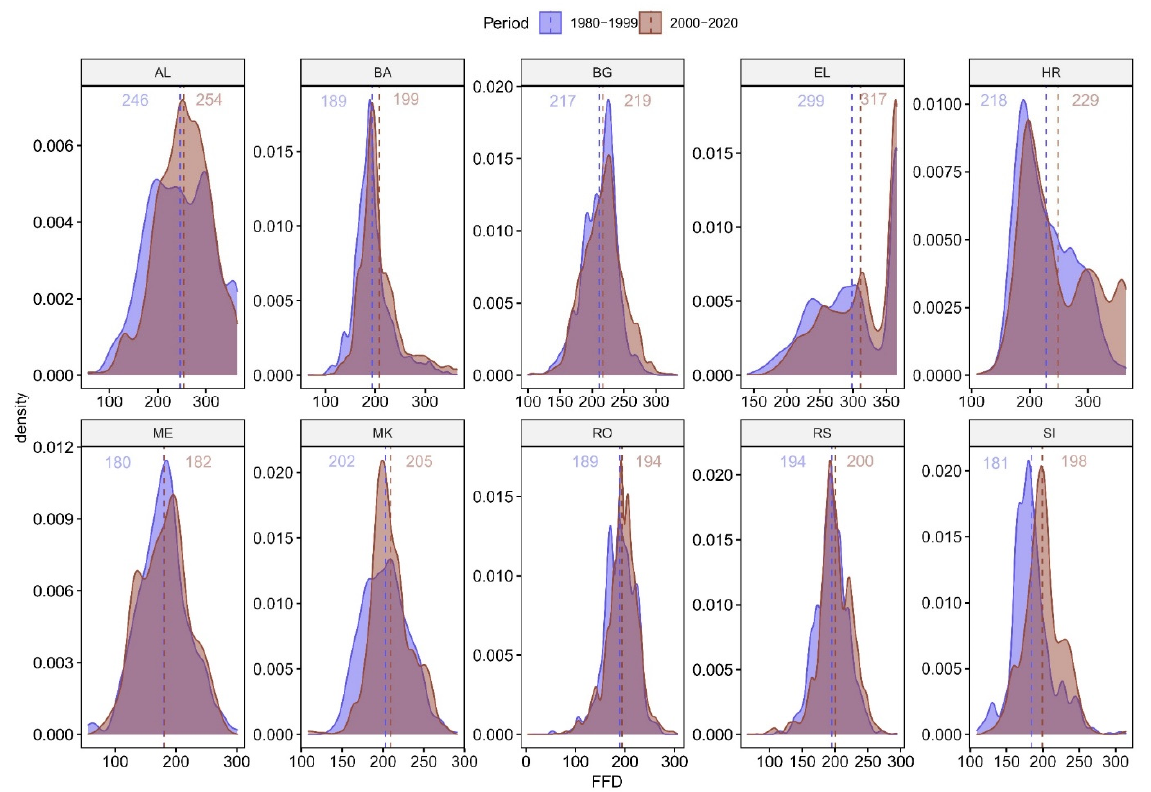
Figure 20. The free of frost days (FFD) probability density per country for the 1980–1999 and the 2000–2020 time periods.